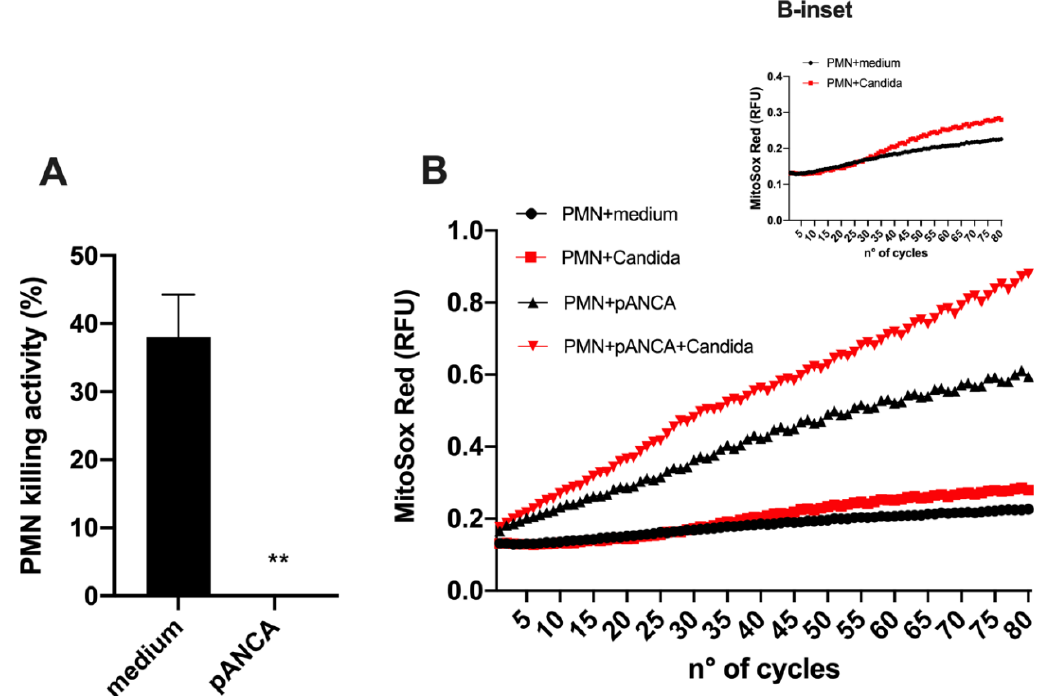
Figure 4. Candidacidal activity. ( A ) Mean ± SEM of the percentage killing activity of human neutrophils (PMN) against C. albicans SC5314 in the presence or absence of pANCA. Significance is indicated with ** p < 0.01. ( B ) Oxidative burst of neutrophils in the presence or absence of pANCA was kinetically analyzed (for 80 cycles, where 1 cycle was 5 min) after in vitro exposure to C. albicans (SC5314). B-inset highlights the oxidative burst of PMN against C. albicans SC5314 (already shown in Panel B) without pANCA treatment. Results are the means of two independent experiments with duplicate samples.